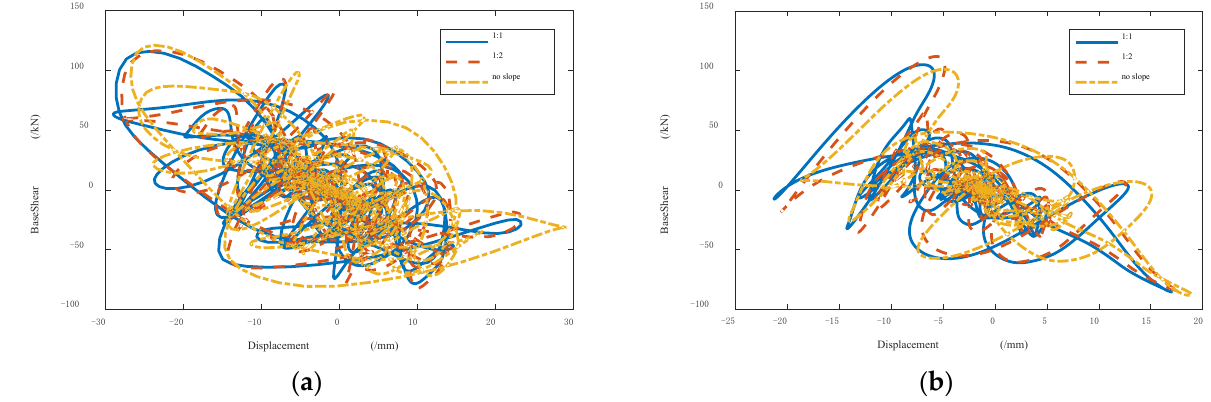
Figure 13. Time history curve of column bottom shear force: ( a ) working condition 6; ( b ) working condition 18.